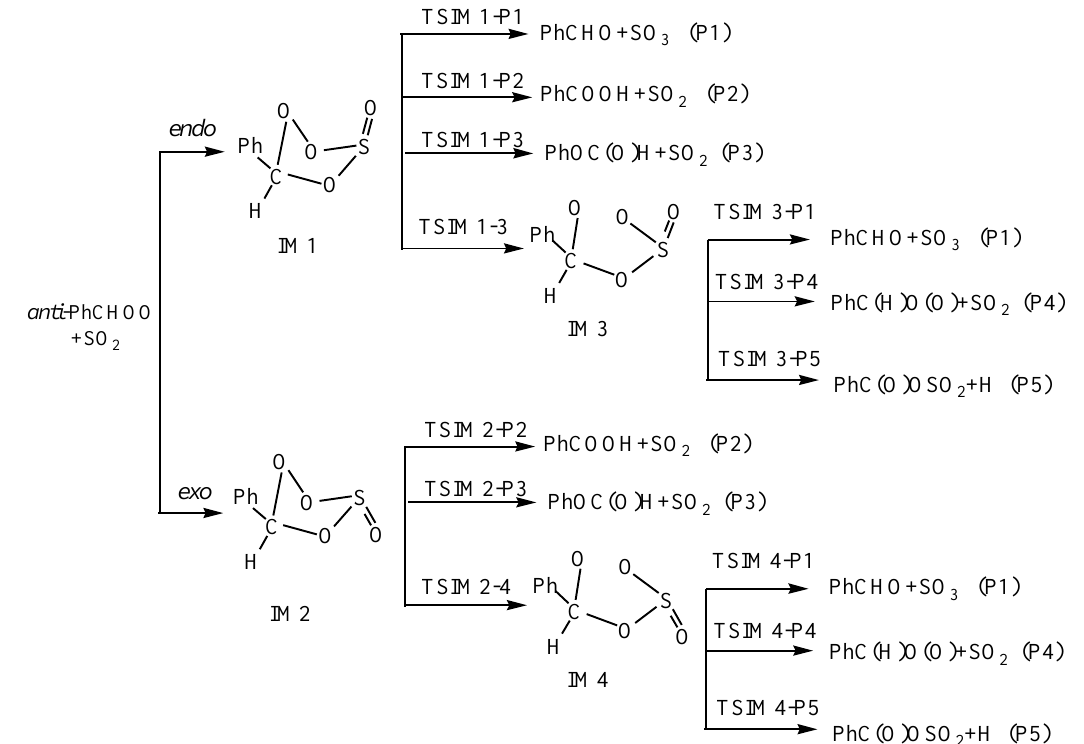
Scheme 1. Proposed mechanisms for the anti -PhCHOO+SO 2